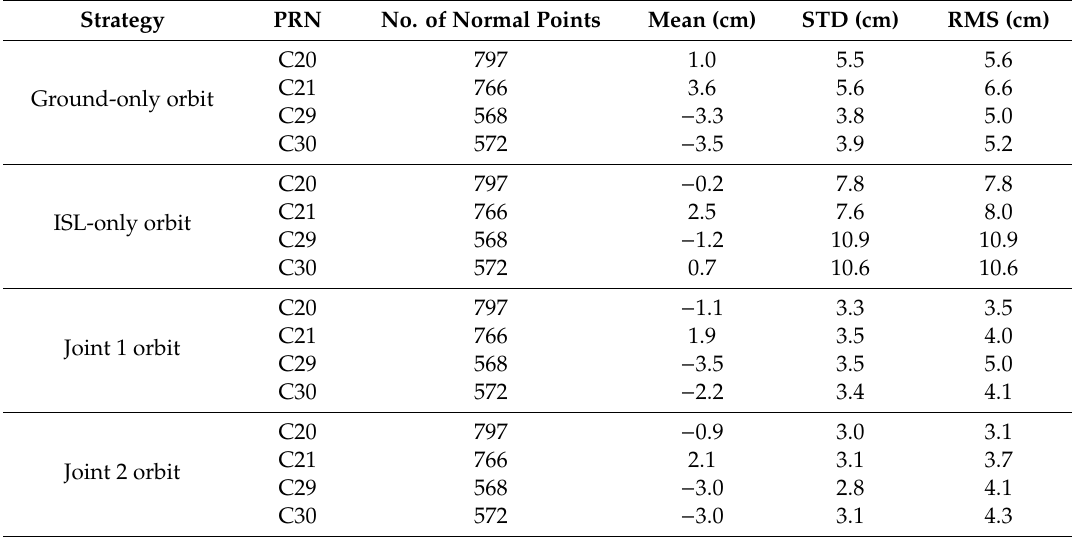
Table 3. SLR residuals to BDS-3 MEO satellites derived from ground-only orbit, ISL-only orbit, Joint 1 orbit, and Joint 2 orbit based on three-day